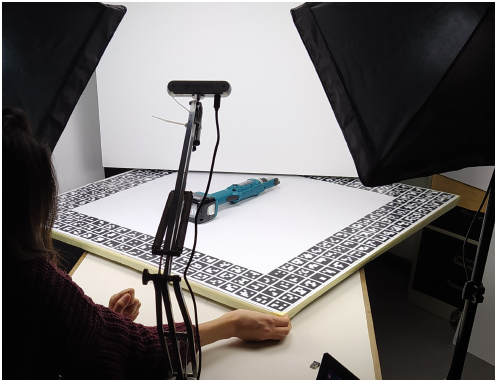
Figure 7. Setup prepared for capturing training and validation images in the laboratory. Objects are placed on a turnable table and the camera is mounted on an adjustable